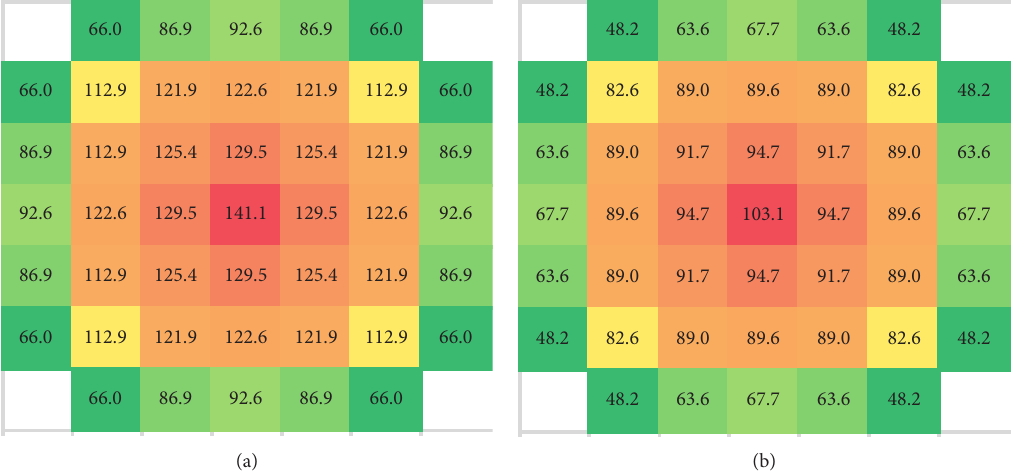
Figure 5: (a) The average power density distribution in the radial middle layer at the BOC (W/cm 3 ); (b) the core average axial power density distribution at the BOC (W/cm 3 ).